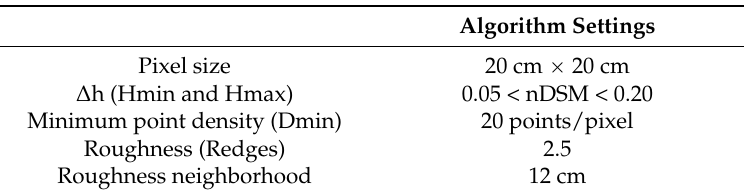
Table 1. Algorithm settings used at Test Site 1.